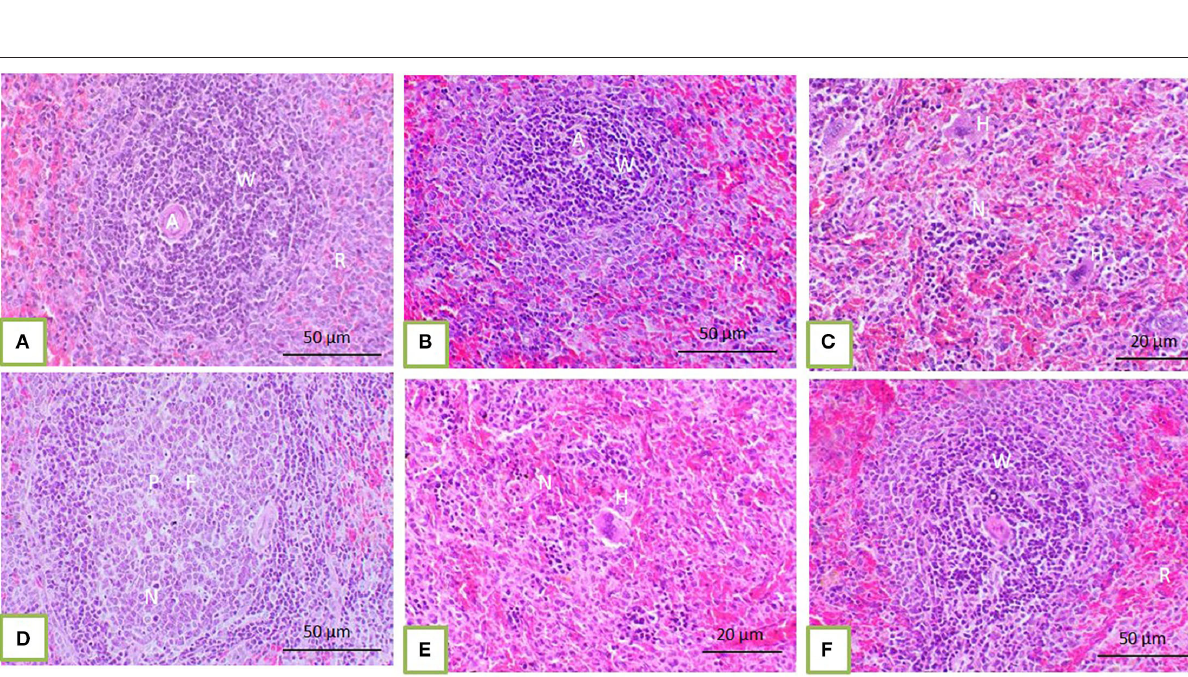
Frontiers in Veterinary Science |